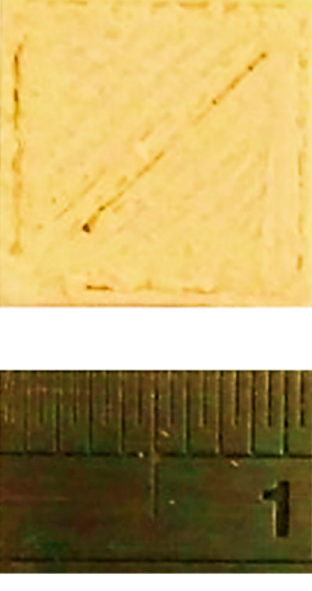
Figure 1. Typical photograph of a 3D-printed nanocomposite photocatalytic sample with 40% w/w TiO 2 in polystyrene (PS).